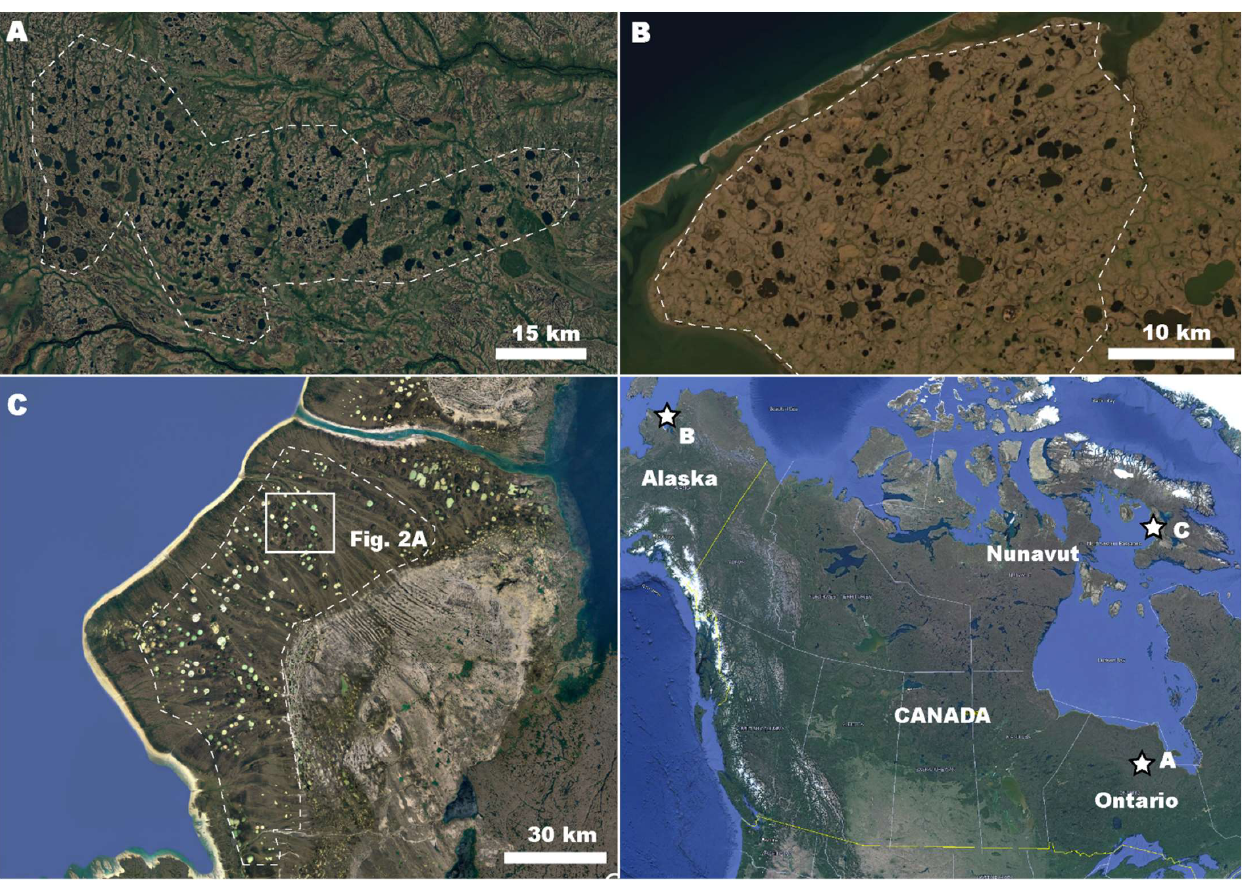
Figure 3. Study areas on Earth. Kettle holes within the dashed lines were measured in each study area. Lower right panel shows the locations of ( A – C ). ( A ) Kettle lakes in northern Ontario, Canada. ( B ) Kettle and thermokarst lakes on Seward Peninsula, Alaska, United States. ( C ) Kettle lakes on Baffin Island, Nunavut, Canada.